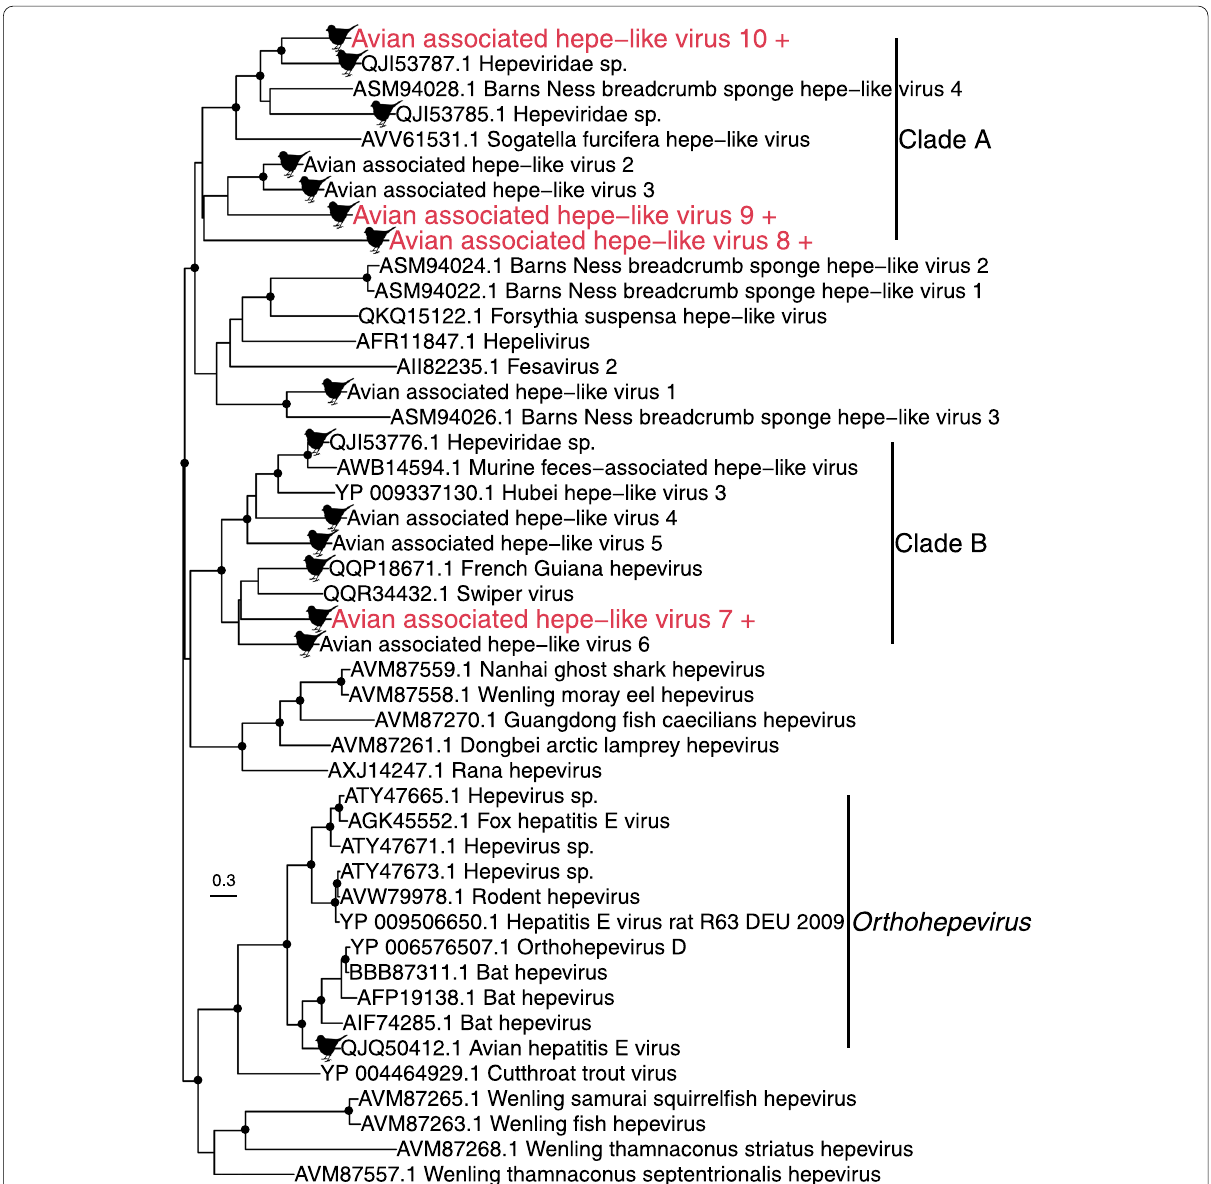
Fig. 3 Phylogeny of the Hepeviridae (representative viruses only) based on the non-structural polyprotein (alignment length of 906 amino acids post trimming). The viruses from this study are shown in red and have a ‘ ’ after their name. Viruses found in birds are marked with a bird silhouette. + Related viruses are shown in black. Black circles on nodes show bootstrap support values of more than 90%. Branches are scaled according to the number of amino acid substitutions per site, shown in the scale bar. The tree is midpoint rooted for purposes of clarity